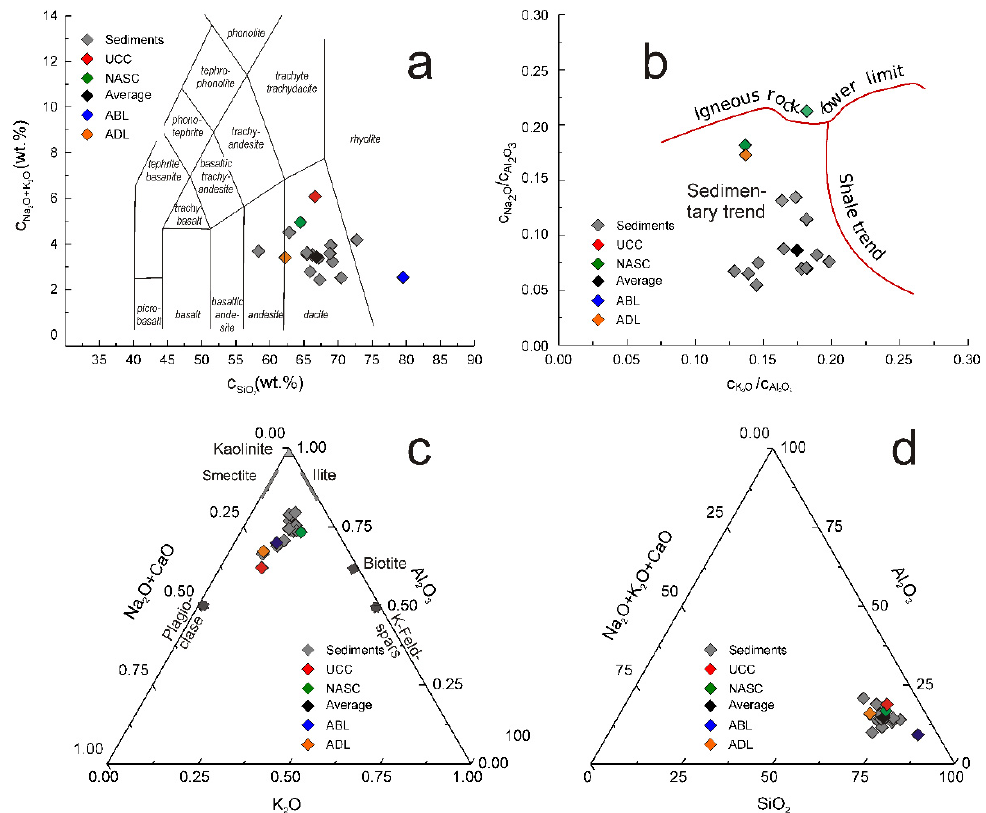
Figure 3. ( a ) The Na 2 O + K 2 O vs SiO 2 and ( b ) Na 2 O/Al 2 O 3 vs. K 2 O/Al 2 O 3 biplots, as well as ternary discriminating diagrams ( c ) K 2 O − Al 2 O 3 − N a 2O + CaO (K-A-CN) and ( d ) SiO 2 − Al 2 O 3 − Na 2 O + K 2 O + CaO illustrating the origin of sedimentary material that composed the investigated sediments. Table 3. The results of multiple-sample ANOVA Mann–Whitney (lower diagonal) and Dunnet post hoc (upper diagonal) tests evidence small differences between the mass fraction distribution of major elements in all 13 samples. Probabilities equal and greater than 85% are illustrated with red